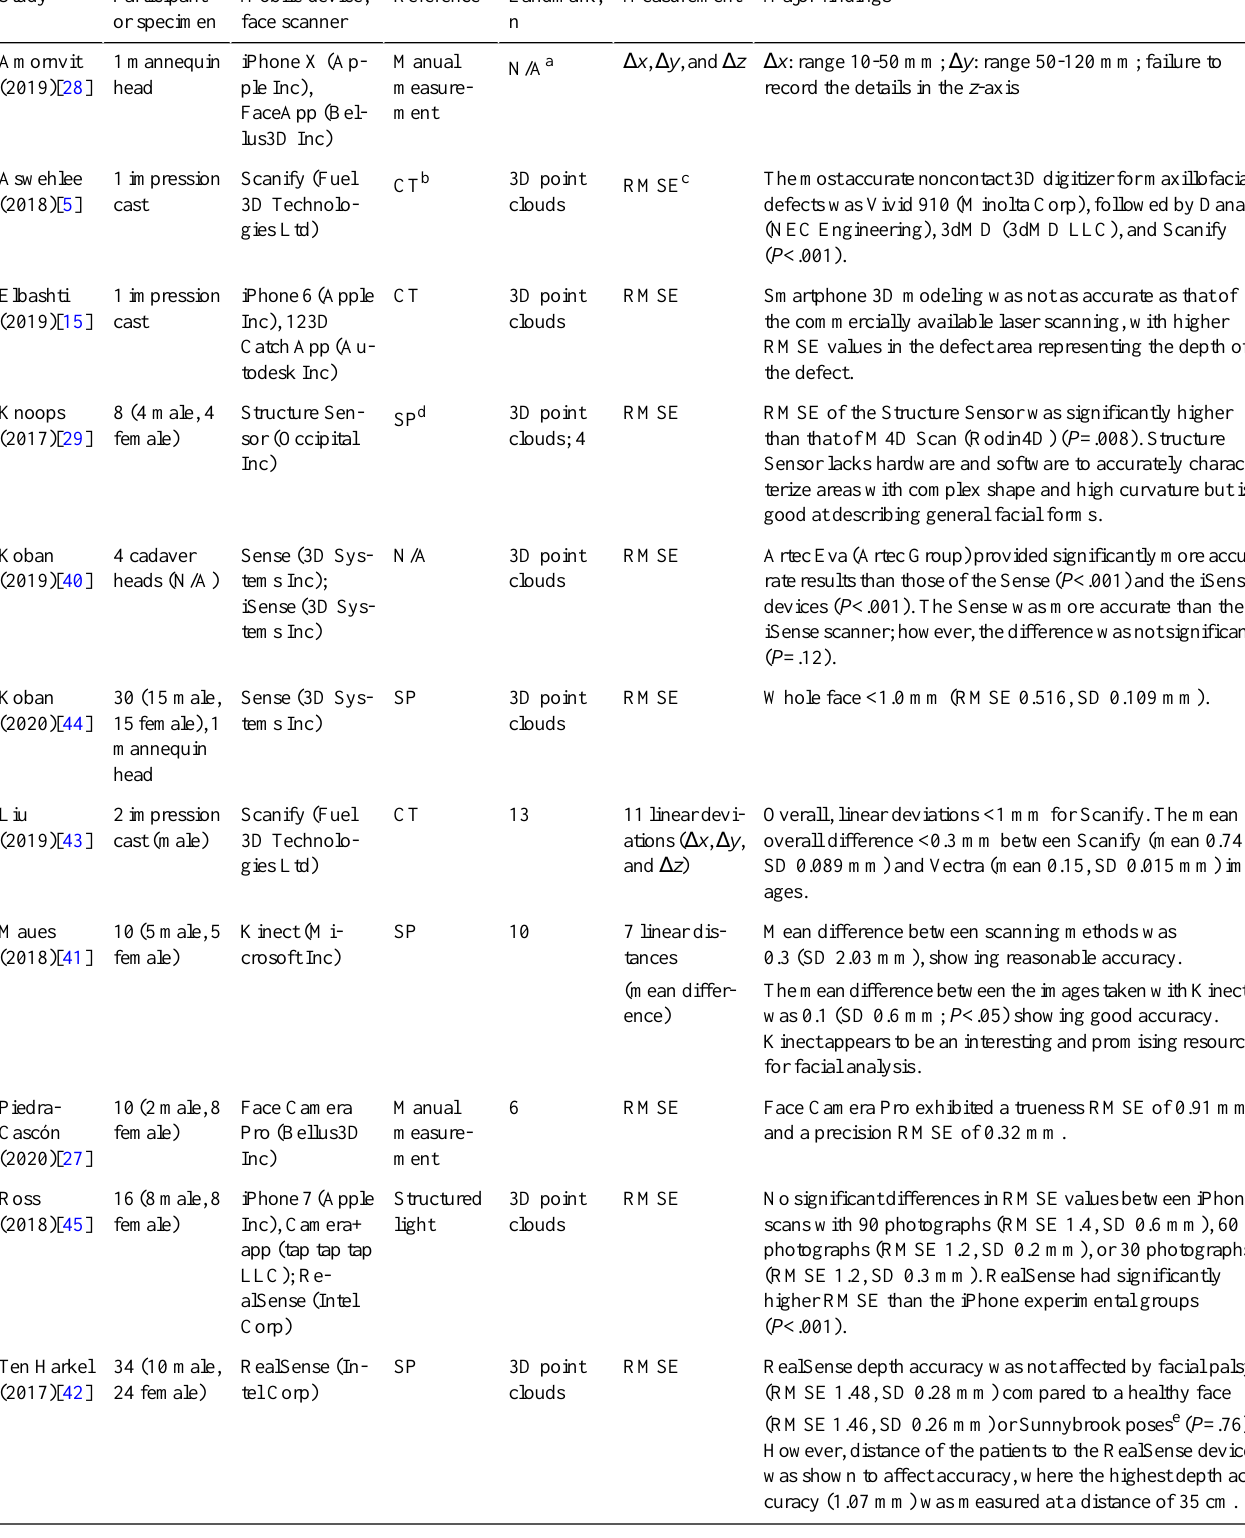
Major findingsMeasurementLandmark, nReferenceMobile device,